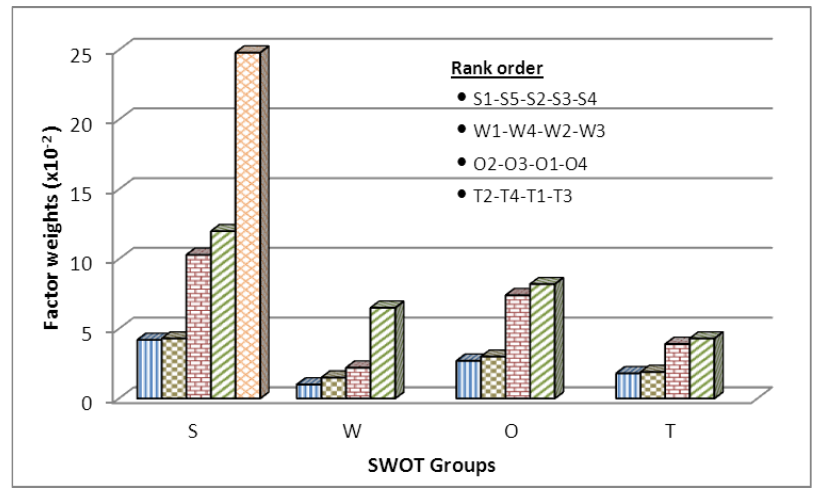
Fig. 2. The overall priority weights of the categorized SWOT sub-factors